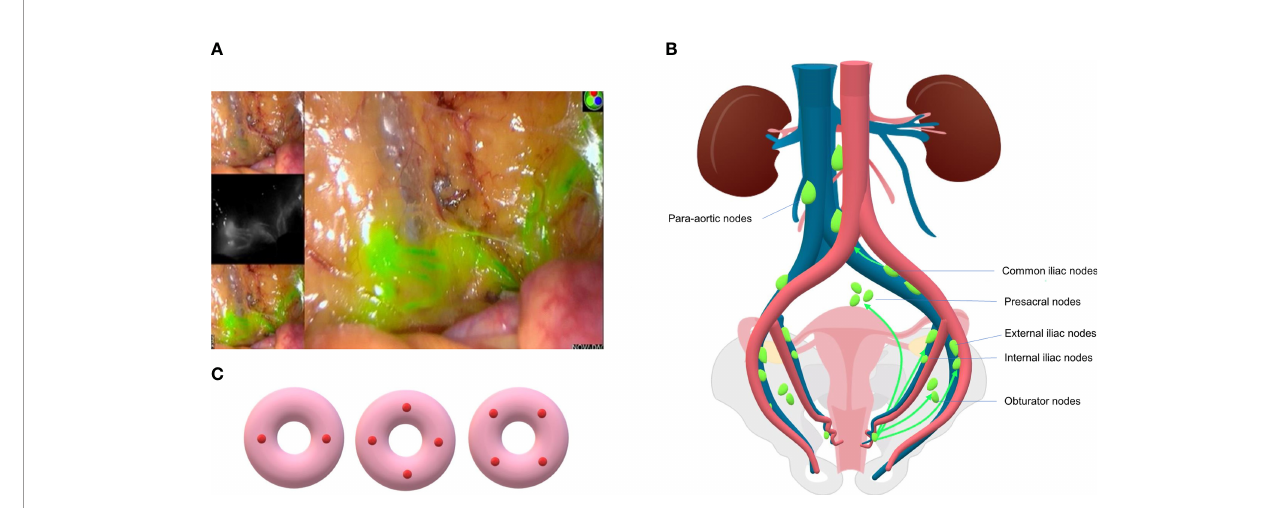
FIGURE 1 | (A) SLN and lymphatic vessel mapped in surgery using ICG dye (Liaoning Pharmaceutical Co., Ltd.) and intraoperative fl uorescence imaging system (PC9000, Novadaq Technologies Inc.). (B) Common lymphatic drainage pathway of endometrial cancer. SLNs are mostly located in external iliac and obturator region and less commonly in presacral and common iliac area. (C) Three patterns of cervical injection sites of SLNM: two sides or four